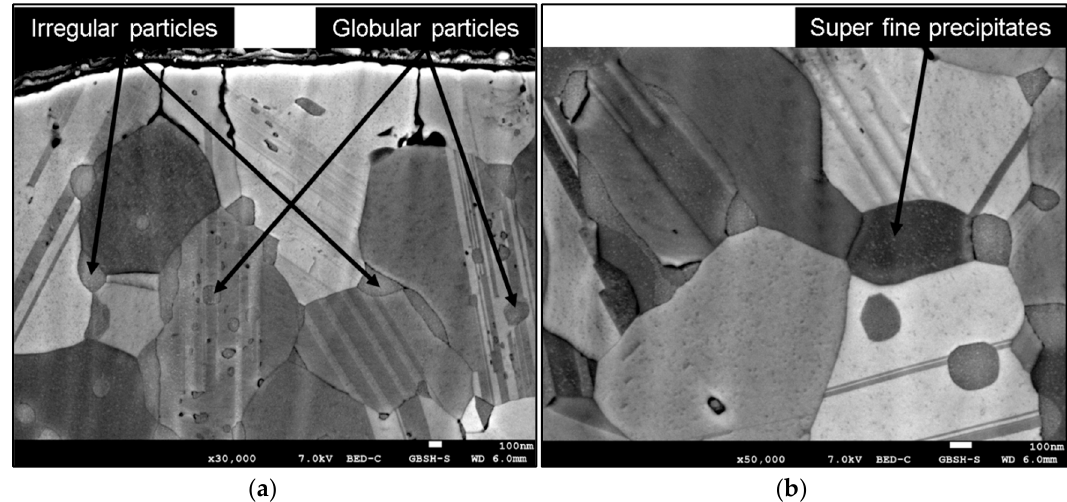
Figure 3. SEM micrograph of a rapidly solidified microstructure in the FEG zone: ( a ) overview of the microstructure; ( b ) detail of the FEG zone.